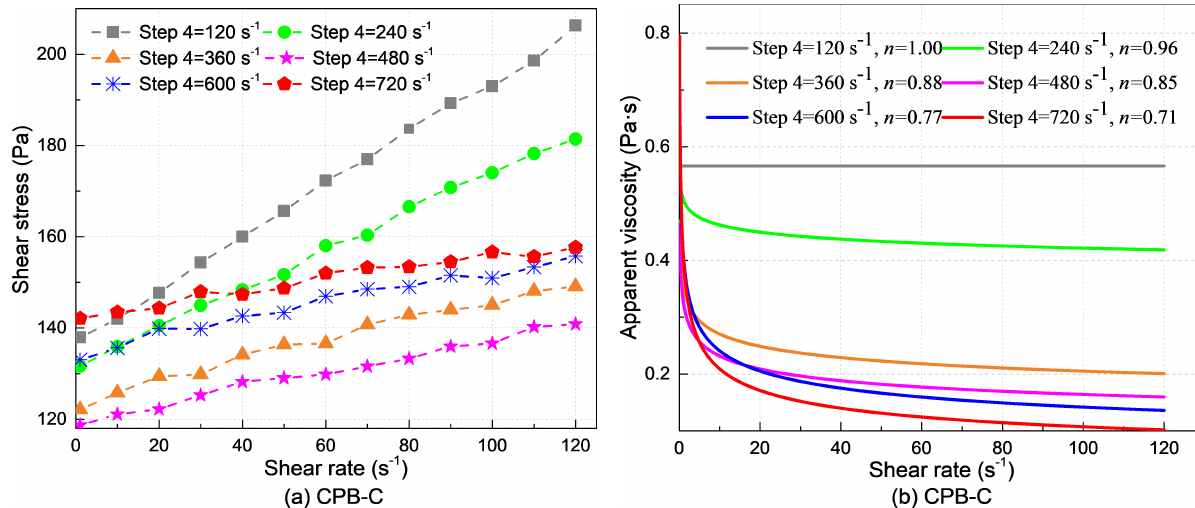
Figure 8: Effect of shear on flow curve behavior of CPB-C.